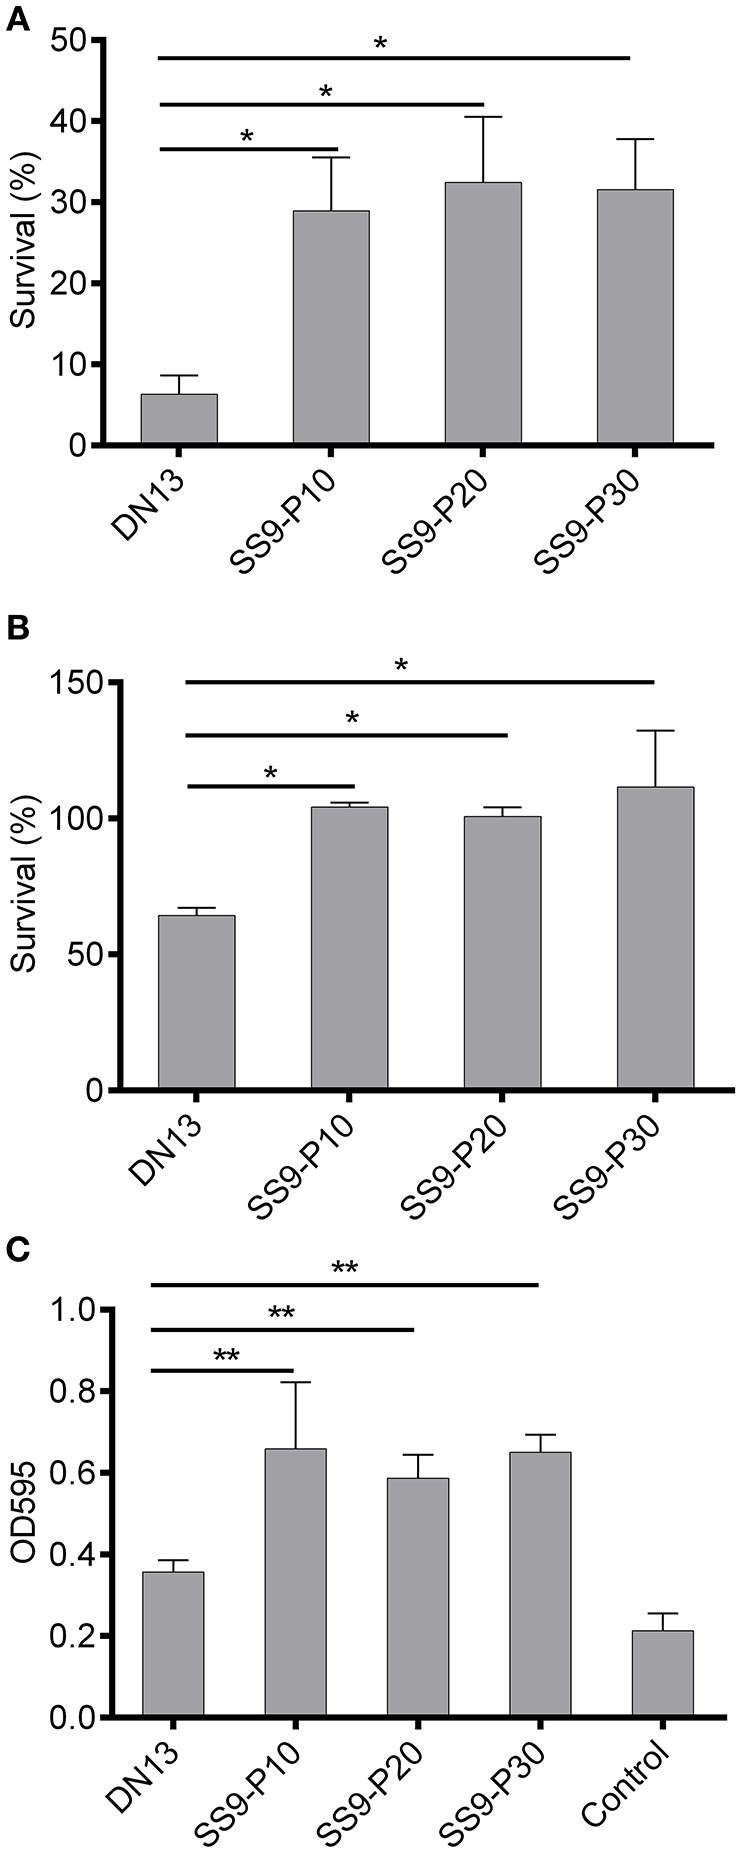
Increased tolerance to oxidative and high-temperature stress and biofilm formation in mouse-adapted Streptococcus suis strains. Exposure of late-log phage S. suis to 0.1 M H2O2 for 20 min was used to evaluate sensitivity to oxidative stress and treatment with sterile PBS was used as the control. The survival percentage was calculated based on the cell number in the H2O2-treatment group divided by the cell number in the control group. Late log-phase S. suis were plated onto BHI agar after six 10-fold dilutions, and growth at 42°C (37°C as the control) was used to induce high-temperature stress. The survival percentage was calculated as with the H2O2 challenge assay. Biofilms were induced by static culture of overnight cultures of S. suis for 3 days. After discarding planktonic bacteria and washing with sterile PBS twice, the biofilm was stained with crystal violet and then biofilm-absorbed dyes were dissolved in acetic acid for readings at OD595 (see materials and methods). In this part, experiments were carried out in duplicate and repeated three times. Values were expressed as mean percentages with standard deviation. One-way analysis of variance (ANOVA) with Kruskal-Wallis test was used to analyze biofilm formation and for oxidative and thermal stress assays. Oxidative stress (A), high temperature stress (B), capacity for biofilm formation (C). *P < 0.05, **P < 0.01.